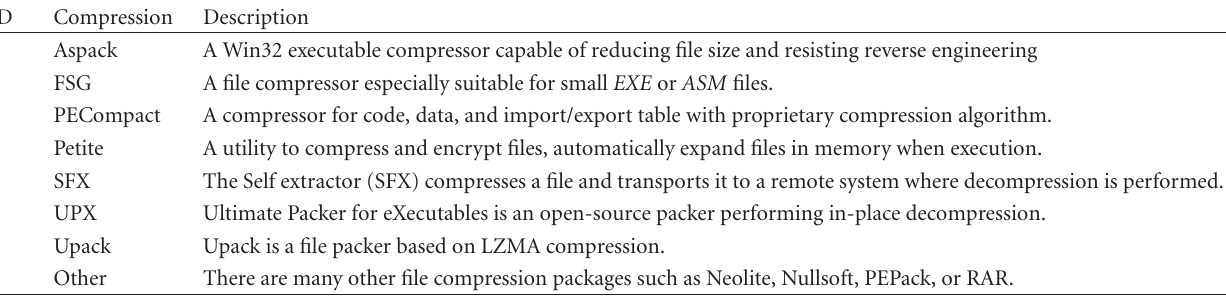
Table 6: File compression types by grayware in encyclopedia of Trend Micro.